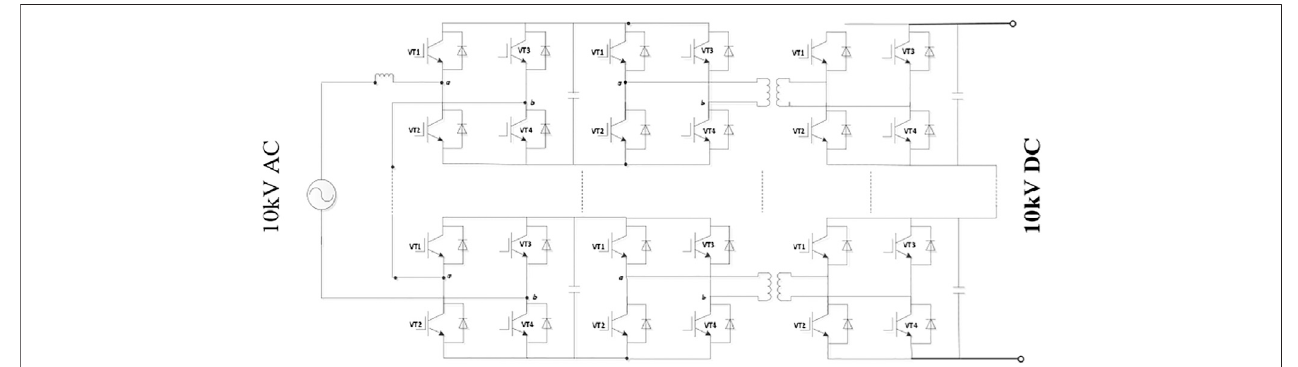
FIGURE 10 | Topology of 10 kV AC-10 kV DC